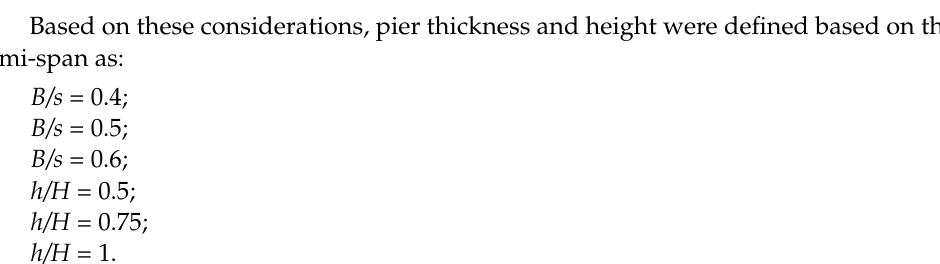
Figure 6. Representation of the empirical rule for the sizing of the buttresses of an arch.